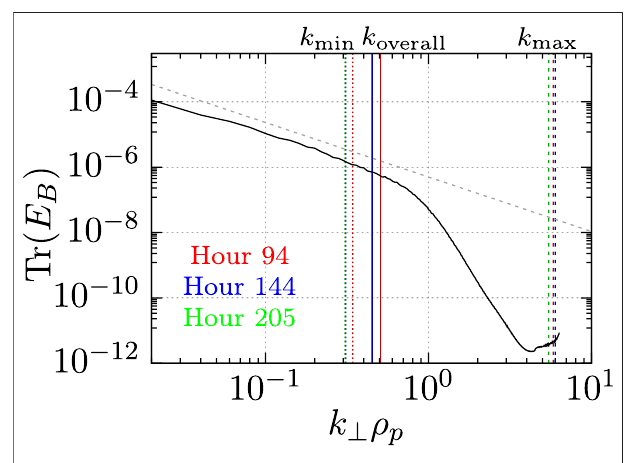
FIGURE 1 | Trace magnetic fi eld spectrum (solid black) from the Gkeyll simulation computed at t (cid:1) 1500/ Ω p , with a k − 5/3 ⊥ dashed line plotted for reference. The characteristic scales associated with the three spacecraft con fi gurations, Hours 94, 144, and 205, drawn from the HelioSwarm DRM are shown as vertical colored